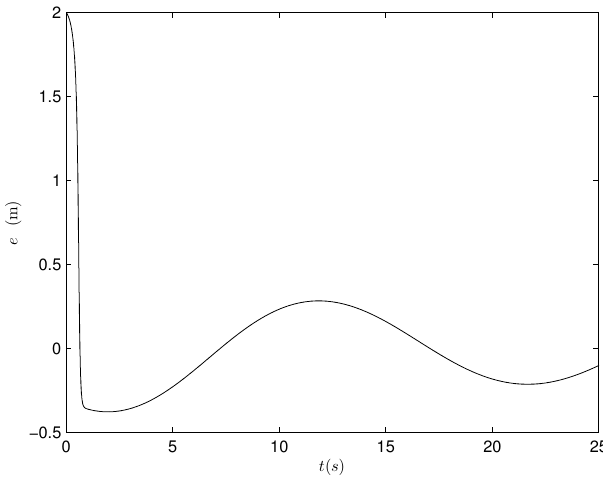
Figure 7. Surge tracking error (traditional adaptive control).